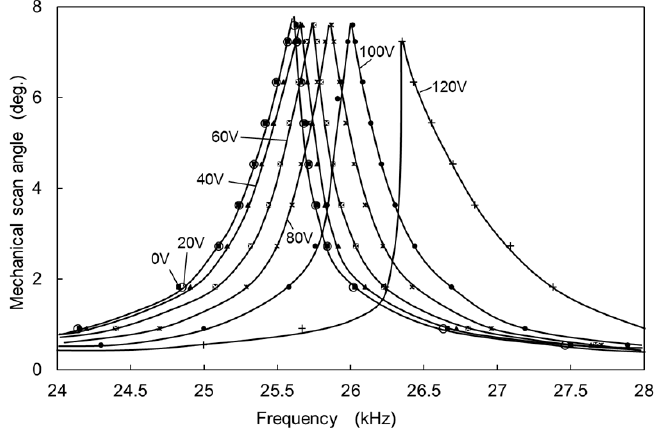
Figure 10. Mechanical scan angle measured as a function of the frequency with the voltage V applied to the compensation combs as a parameter.